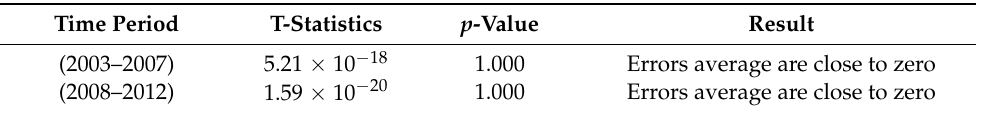
Table 5. The results of the Student’s t